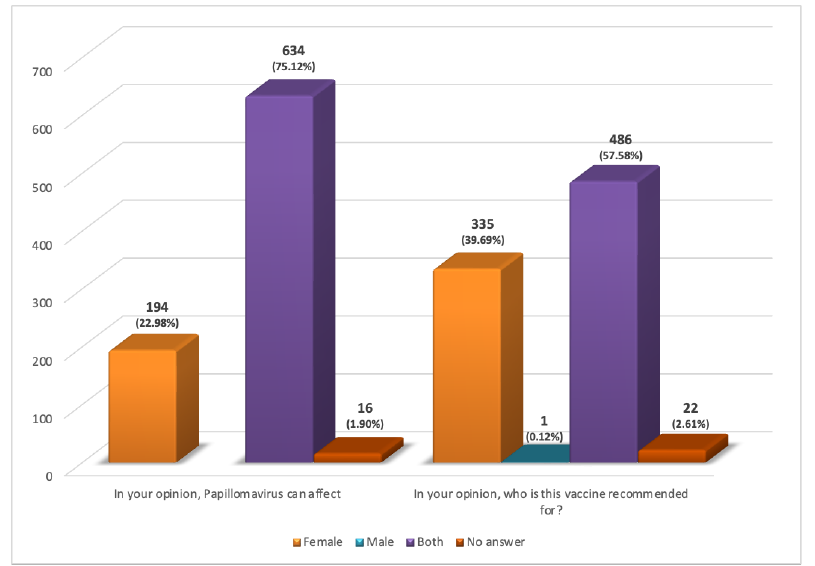
Figure 2. Answers of respondents to the items: #7 In your opinion, papillomavirus can affect? and #9